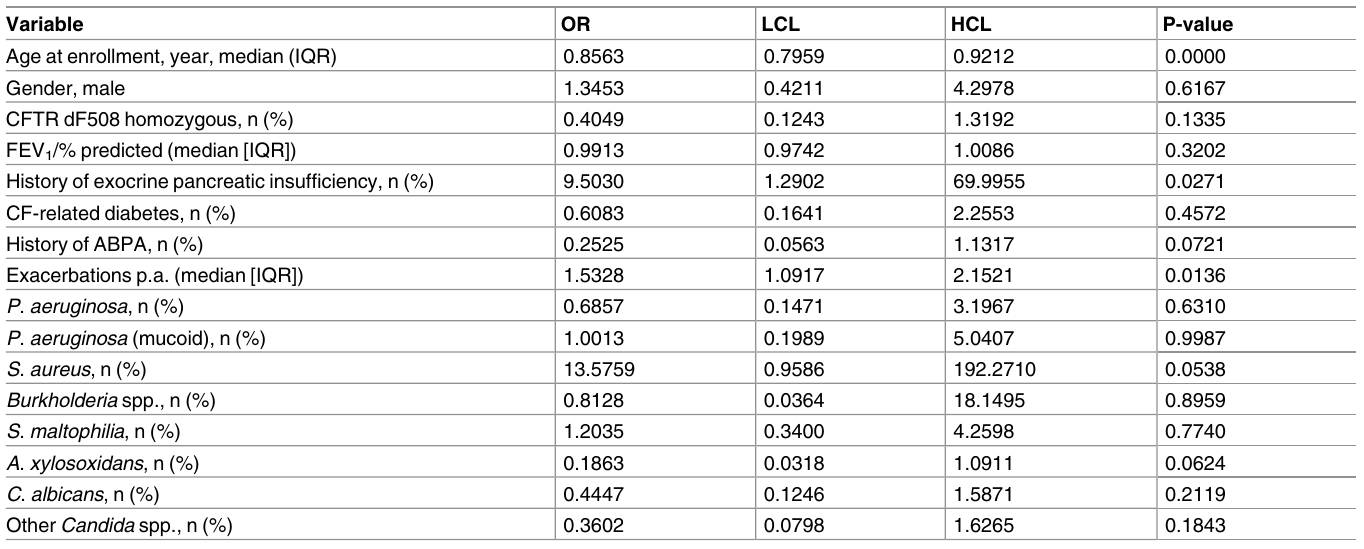
Table 4. Adjusted odds ratios for association factors of H . influenzae colonization (total n = 161 patients).